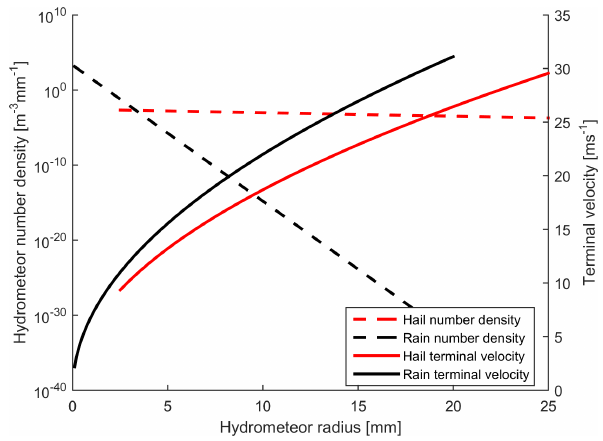
Figure 3. Example of the hydrometeor number density (d N/ d R ; number of droplets per meter cubed of air per millimeter of radius increment) for a precipitation rate of 25mmh − 1 for rain droplets (as described using the Marshall–Palmer size distribution) and for hail stones (for D 75 of 25mm and λ = 0 . 053mm − 1 ) (left axis). Note: the λ value employed ( λ = 0 . 053mm − 1 ) differs from the range ( λ : 0.1 to 2mm − 1 ) used by Cheng and English (1983) for the seven events they sampled and thus corresponds to a larger maximum hail size. Hydrometeor terminal velocities of hail and rain are shown by radius on the right axis.